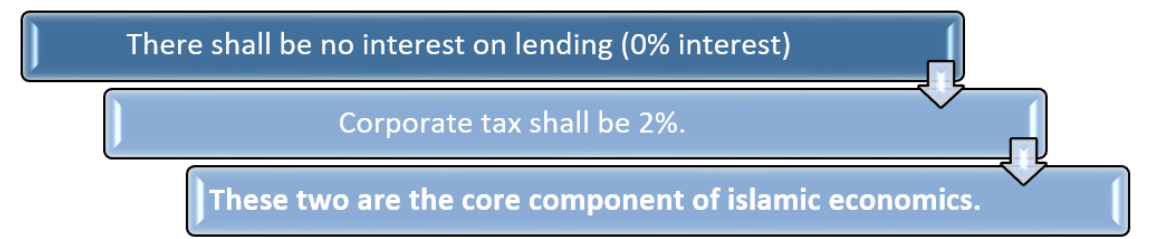
Figure 6. Core competencies of the Islamic economics.